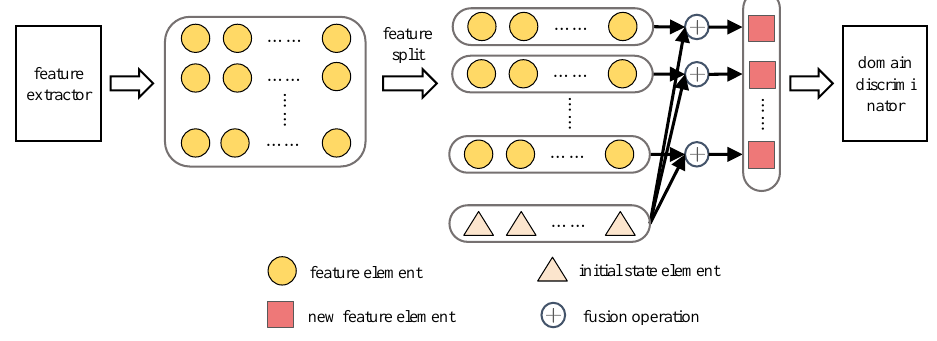
Figure 1. Initial state fusion